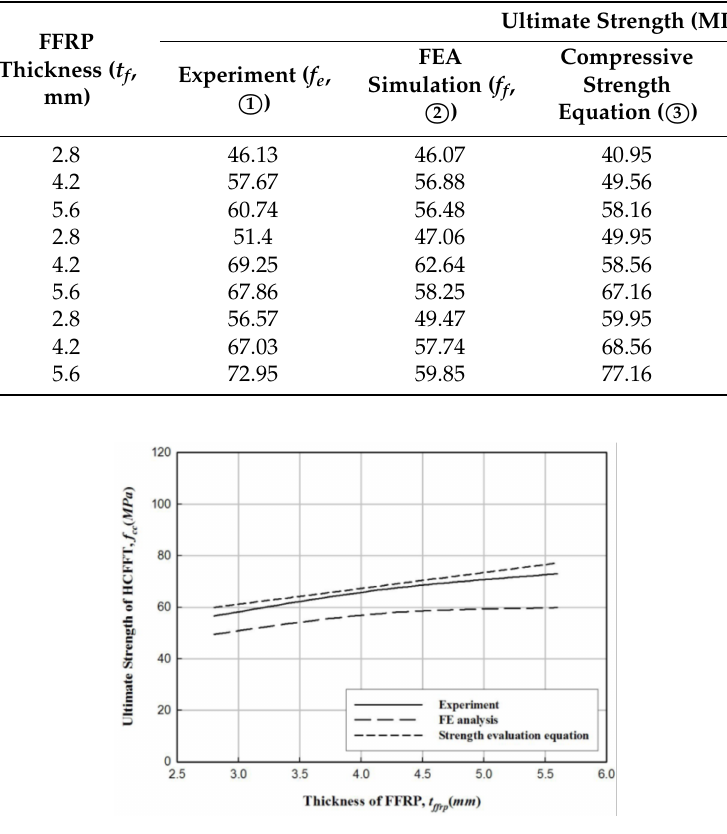
Figure 23. Hybrid − CFFT analysis results comparison ( f co = 40 MPa).